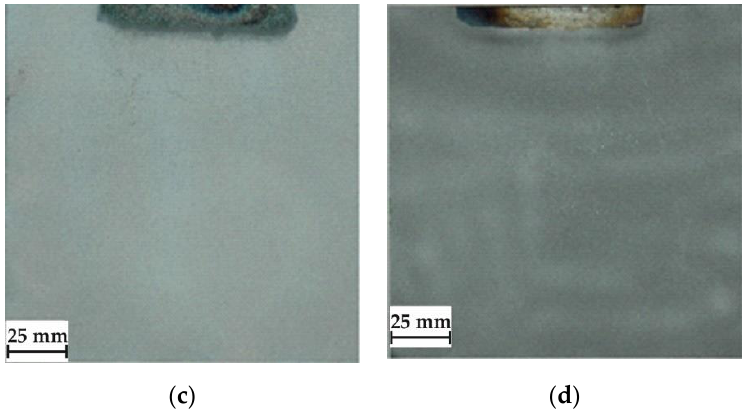
Figure 2. View of test samples with flame-sprayed coatings on the aluminum matrix: ( a ) aluminum powder of the EN AW 1000 series; ( b ) aluminum powder EN AW 1000 series with addition of 0.5 wt.% carbon nanotubes (Nanocyl NC 7000); (c ) aluminum powder of the EN AW 1000 series with the